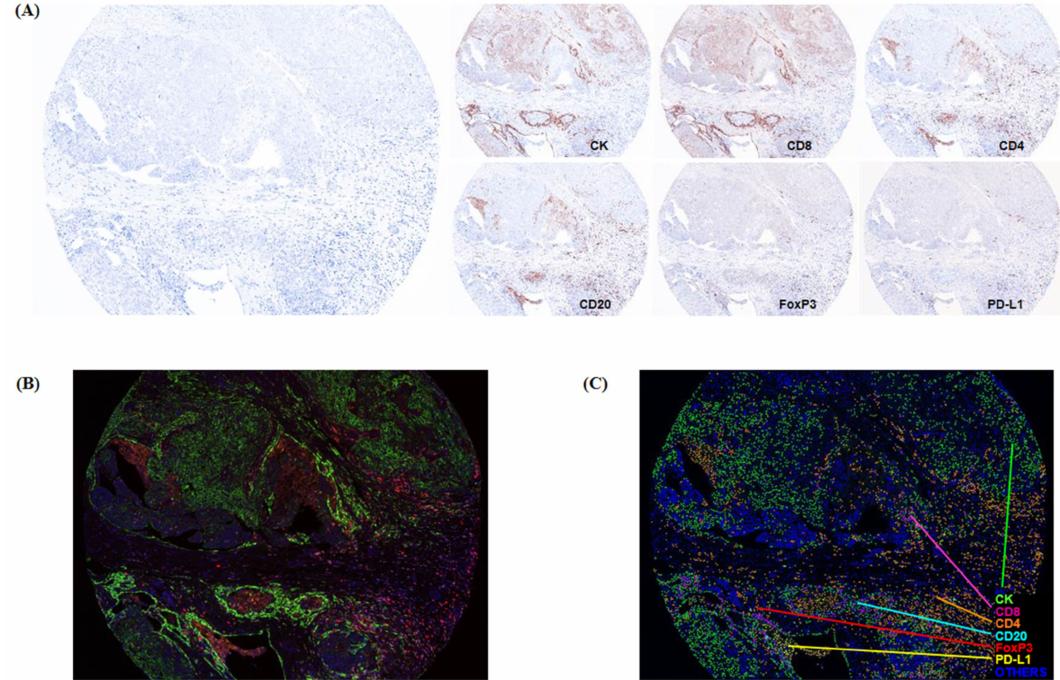
Figure 1. The Opal multiplexed immunohistochemical staining and quantitative analysis. ( A ) The simultaneous staining result of multiple biomarkers, including CK, PD-L1, CD20, CD4, CD8, and FoxP3. ( B ) A composite image was produced according to the spectral library for each fluorescent probe (Opal 520, Opal 540, Opal 570, Opal 620, Opal 650, Opal 690, and DAPI). ( C ) Automatic phenotyping of HGSOC TMA tissue as a previously designated color (green, CK; yellow, PD-L1; sky blue, CD20; orange, CD4; pink, CD8; red, FoxP3; blue,